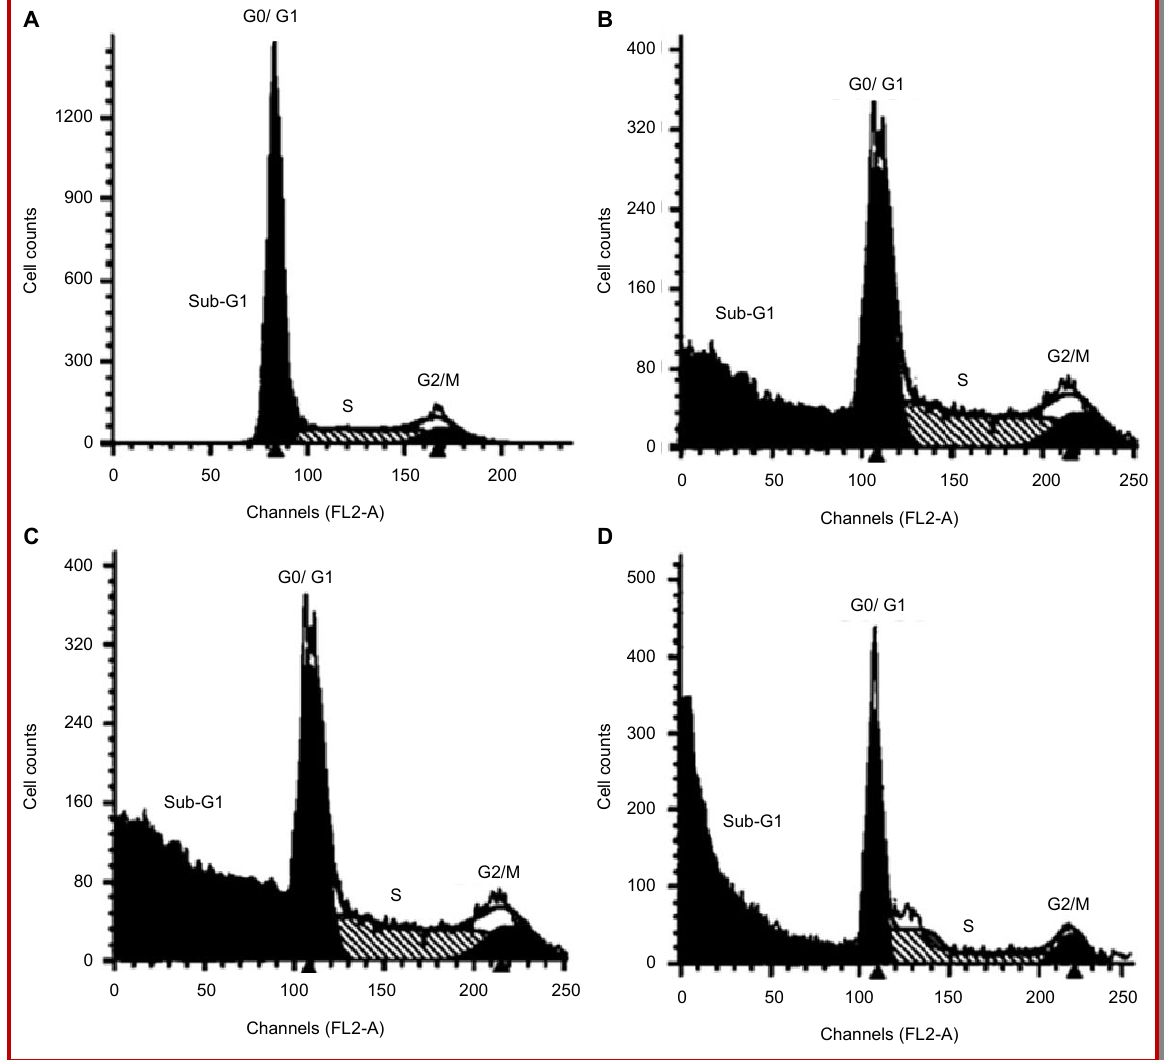
Figure 6: Effect of lactucin on the cell cycle phase distribution in HL-60 human leukemia cancer cells. The cells were treated with-out (A) and with 5 (B), 50 (C) and 100 (D) µM dose of lactucin for 48 hours and then analyzed by flow